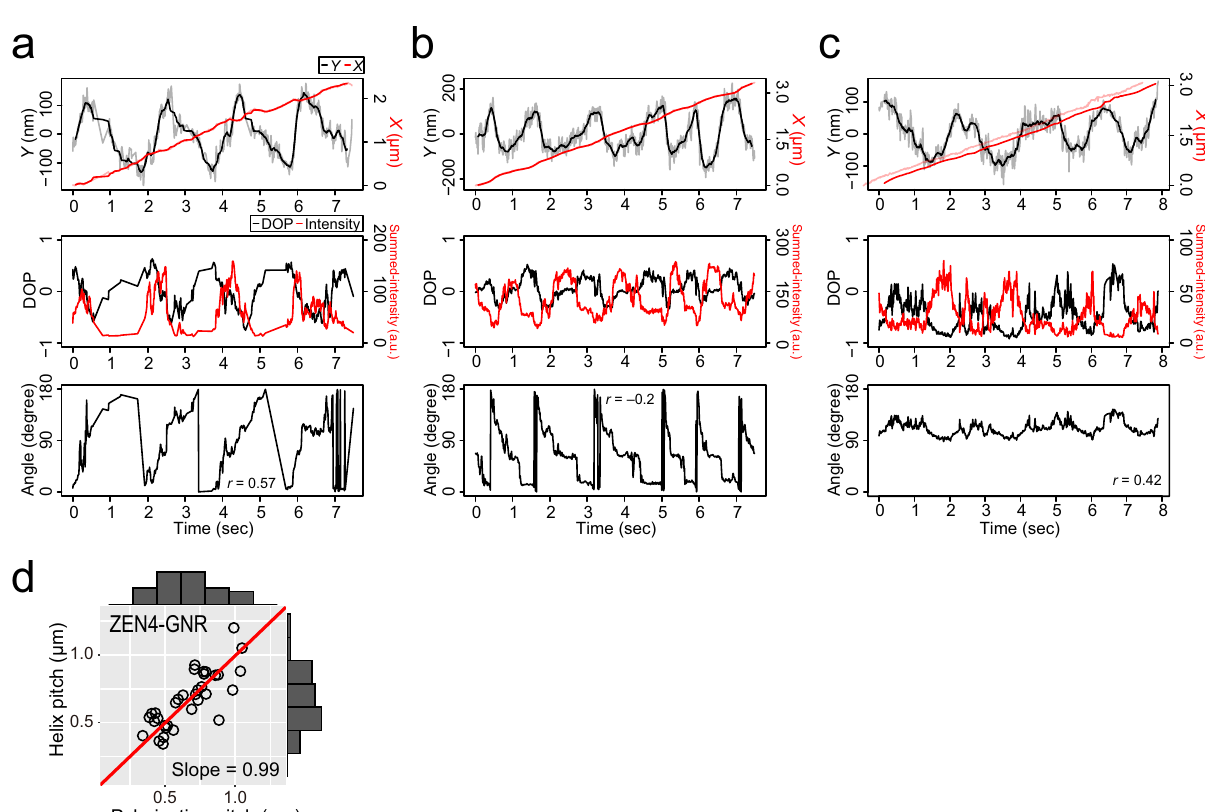
Fig. 5 GNR motility assay for ZEN-4. a – c Typical time trajectories of the X (red line)- and Y (black line)-displacements, the degree of polarization (DOP, black line) and summed-intensity (red line) of the two spots, and the estimated angles of ZEN-4-coated gold nanorods (ZEN4-GNRs). The three trajectories represent counterclockwise ( a ), clockwise ( b ), and oscillatory ( c ) rotations of the GNR polarization in the sample plane. The value of r is Pearson ’ s correlation coef fi cient between the Y -displacement and the angle. d Distribution of the helix and polarization pitches of ZEN4-GNRs. The red lines represent linear fi ts ( y = ax ) of which the slopes ( a ) are 0.99 ( R 2 =